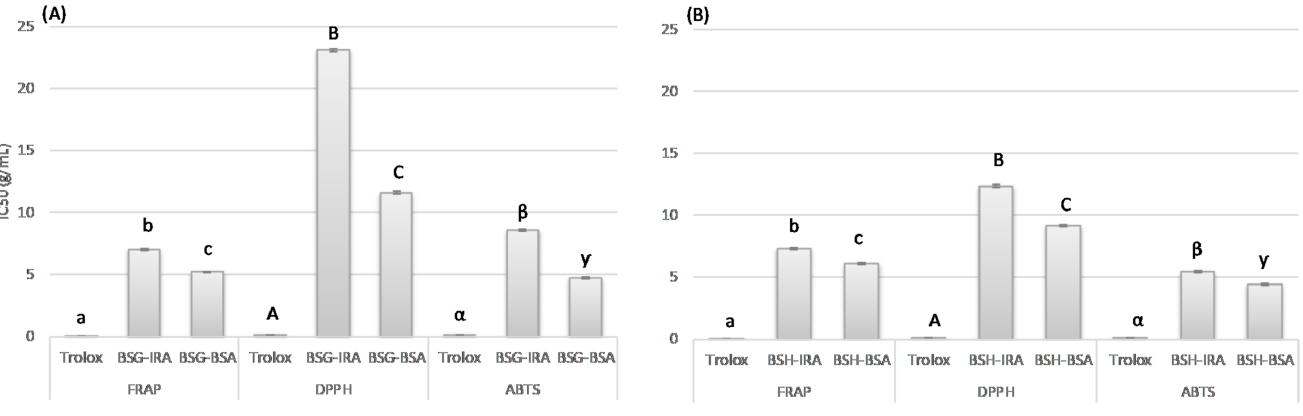
Figure 3. Antioxidant activities of the brewing spent grains, BSG ( A ) and brewing spent hop, BSH ( B ) samples (IC50); n = 3; IRA = Imperial red ale; BSA = Belgian strong ale; IC50 = The median inhibitory concentration. Different letters and symbols in each column graph denote significant differences between samples ( p ≤